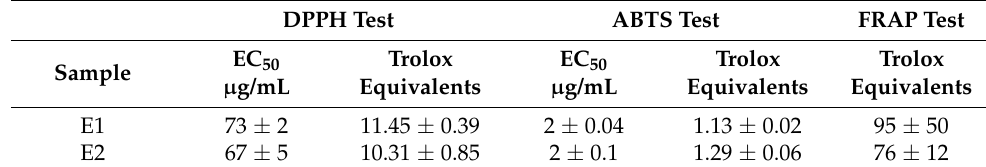
Table 7. Antiradical activity of the tested C. sativa extracts.